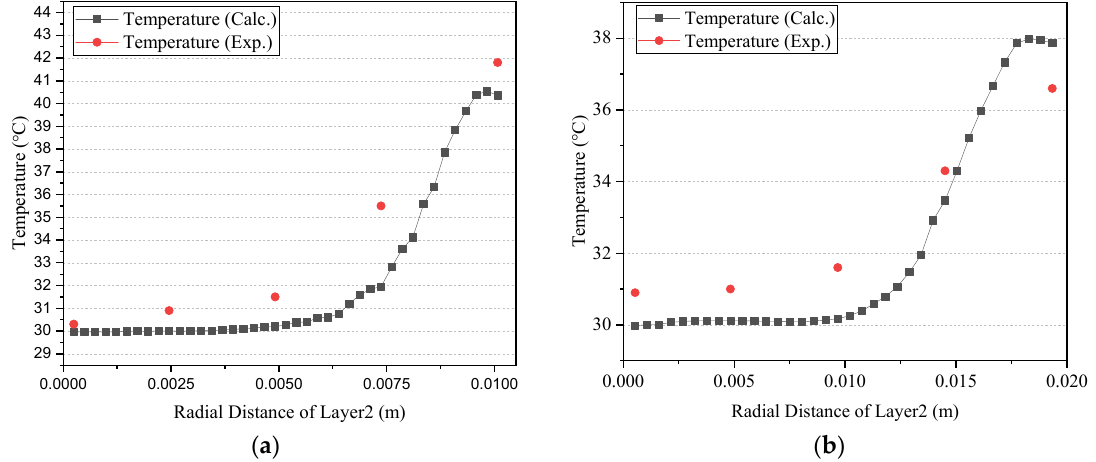
Figure 16. Temperature comparisons for three pulleys of two-belt drive systems: belt drive layout ( a ) 1 and ( b ) 2.